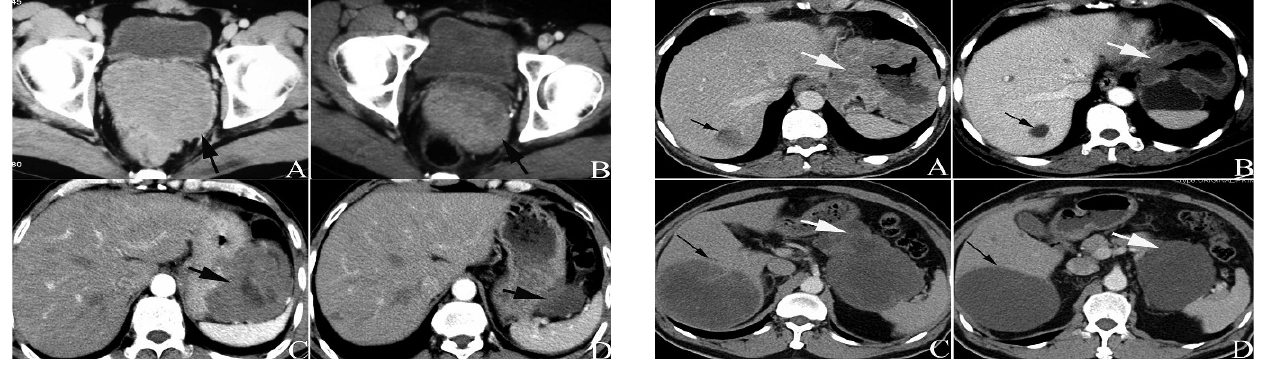
Figure 2 - This CT scan obtained after medical treatment depicts tumors located in the pelvic cavity (AB) and greater curvature (CD) that significantly decreased in size and density (indicated by arrows). Patient no. 4 (CD) died at 25 months after diagnosis due to disease progression.